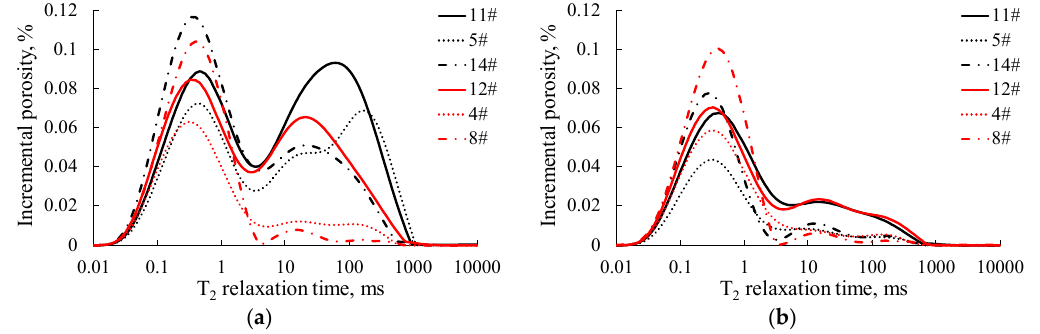
Figure 10. NMR T 2 distributions of specimens ( a ) before and ( b ) after centrifugations.